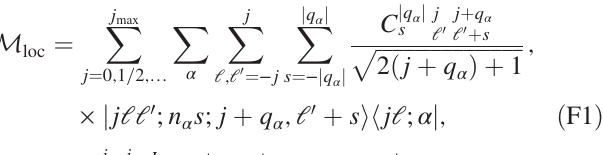
FIG. 13. Difference in the total entropy for the RDM for the leftmost L sites between simulation results obtained with ε ¼ 10 − 10 and ε ¼ 10 − 6 . The panels show the results for N ¼ 200 , x ¼ 50 , m=g ¼ 0 . 1 (a) and m=g ¼ 0 . 3 (b). The blue dots indicate 1 = 2 , the green squares j 2 . j max ¼ max ¼